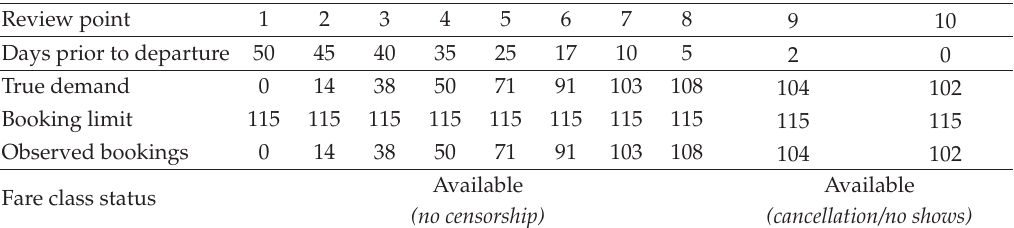
Table 1: Review point to days prior to mapping and booking matrix without demand censoring of a fare class.